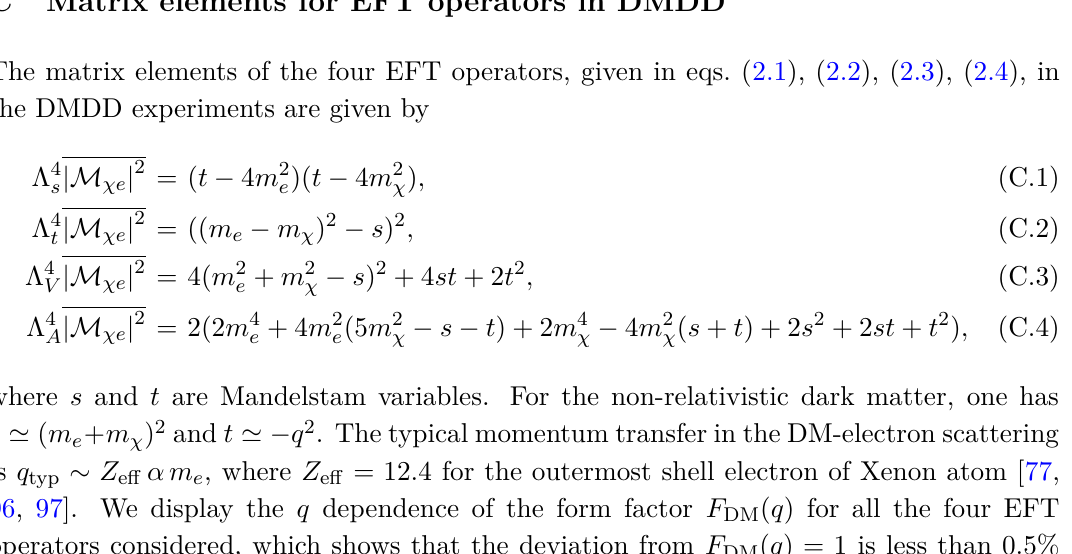
where Z = 12 . 4 . We use m = 1 MeV eff α m e eff χ